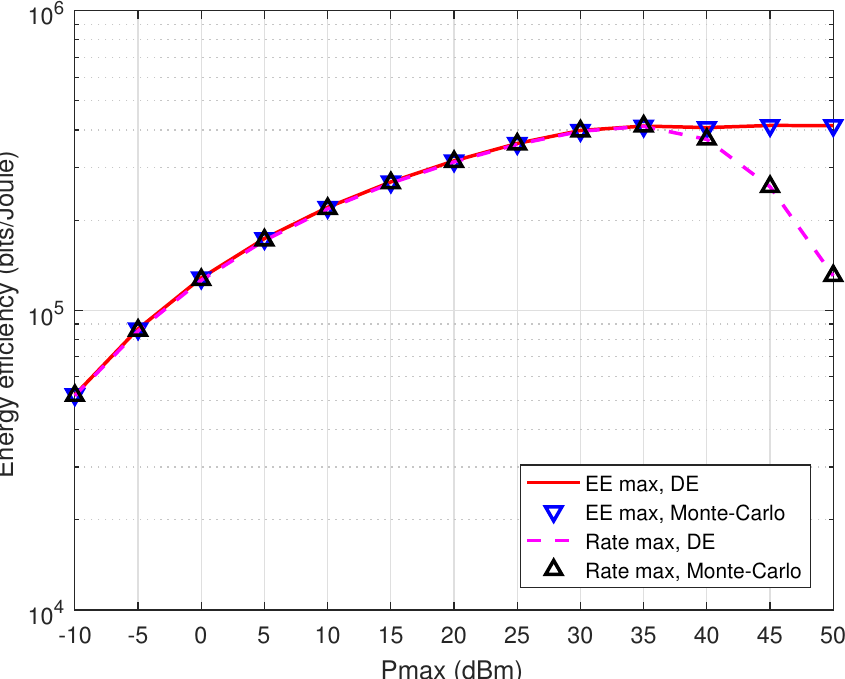
Figure 2. Comparison of the EE performance between the proposed EE maximization approach and the conventional multicast rate maximization approach. The depicted results are shown versus the multicast power budget P max . The DE results of both approaches are also